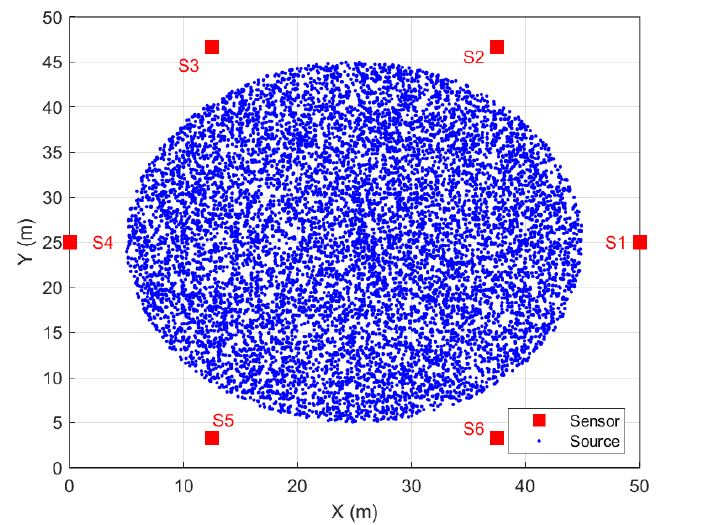
Figure 4. Random source distribution over the search space for N =